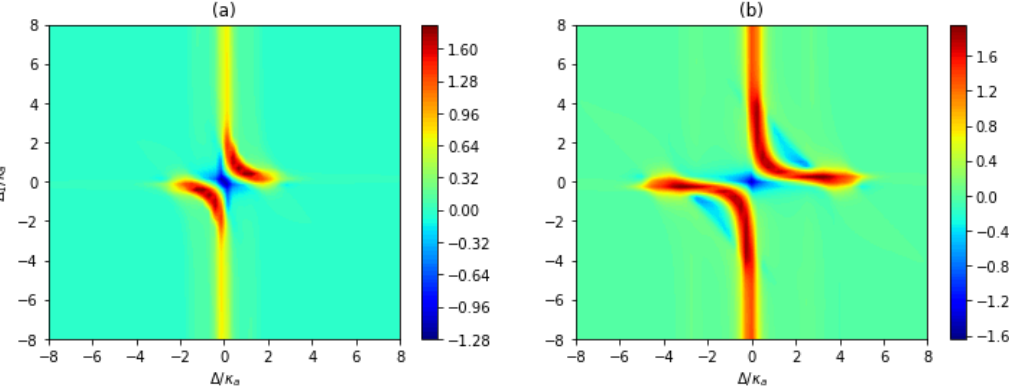
( 2 ) ( 0 ) as a function of the scaled